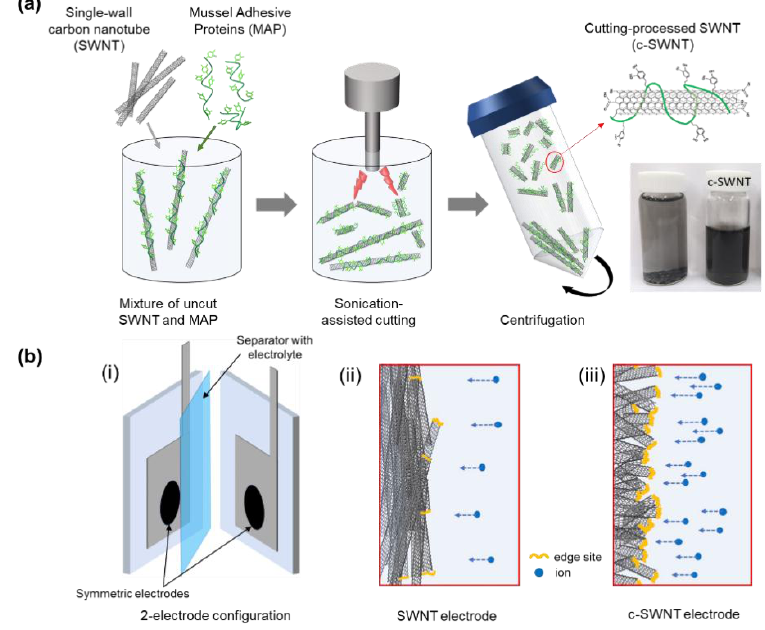
Figure 1. ( a ) The schematic of the synthesis process of short-cut SWNT (c-SWNT) and photographs of carbon nanotube suspension before and after cutting process ( b ) Schematic illustration of the supercapacitor structure (i) and electrodes using (ii) SWNTs and (iii) c-SWNTs. The short structure of c-SWNT preferentially exposes the active edge sites during operation.